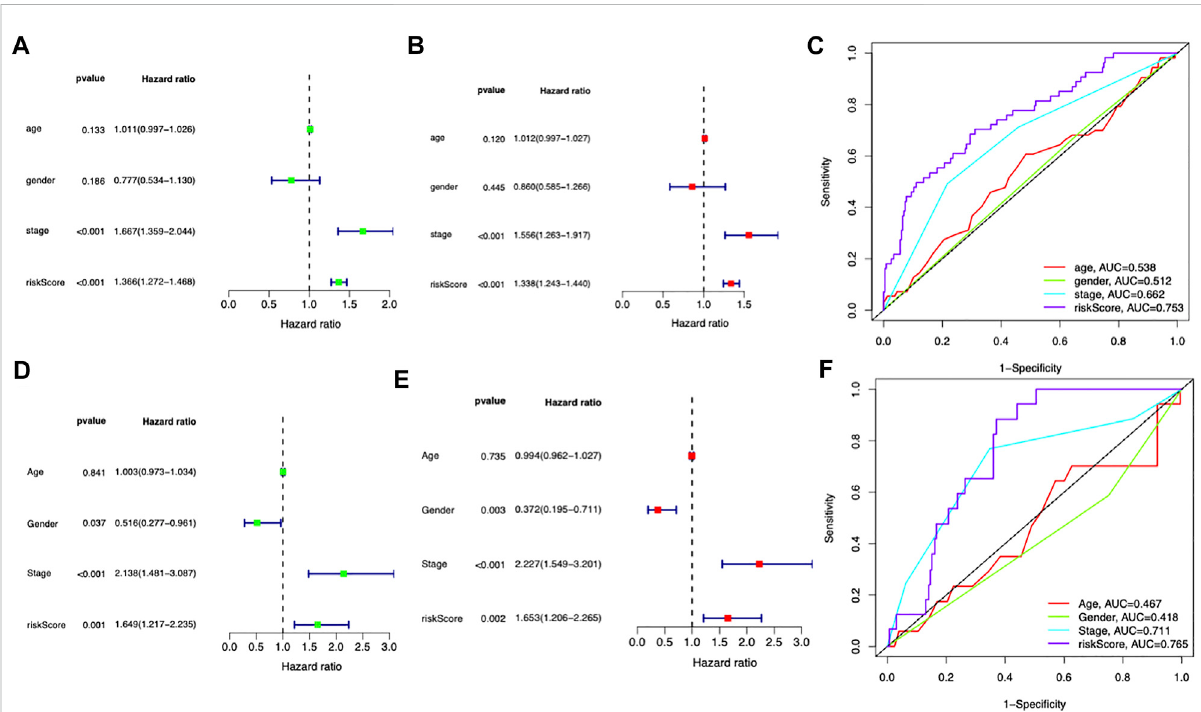
FIGURE 4 Independent prognostic role of the prognostic signature. (A,B) Univariate and multivariate Cox analyses for the prognostic model and other clinicalfeaturesintheTCGAcohort. (C) ROCanalysisoftheriskscoreandotherclinicalfeaturesintheTCGAcohort. (D,E) Univariateandmultivariate Cox analyses for the prognostic model and other clinical features in the ICGC cohort. (F) ROC analysis of the risk score and other clinical features in the ICGC